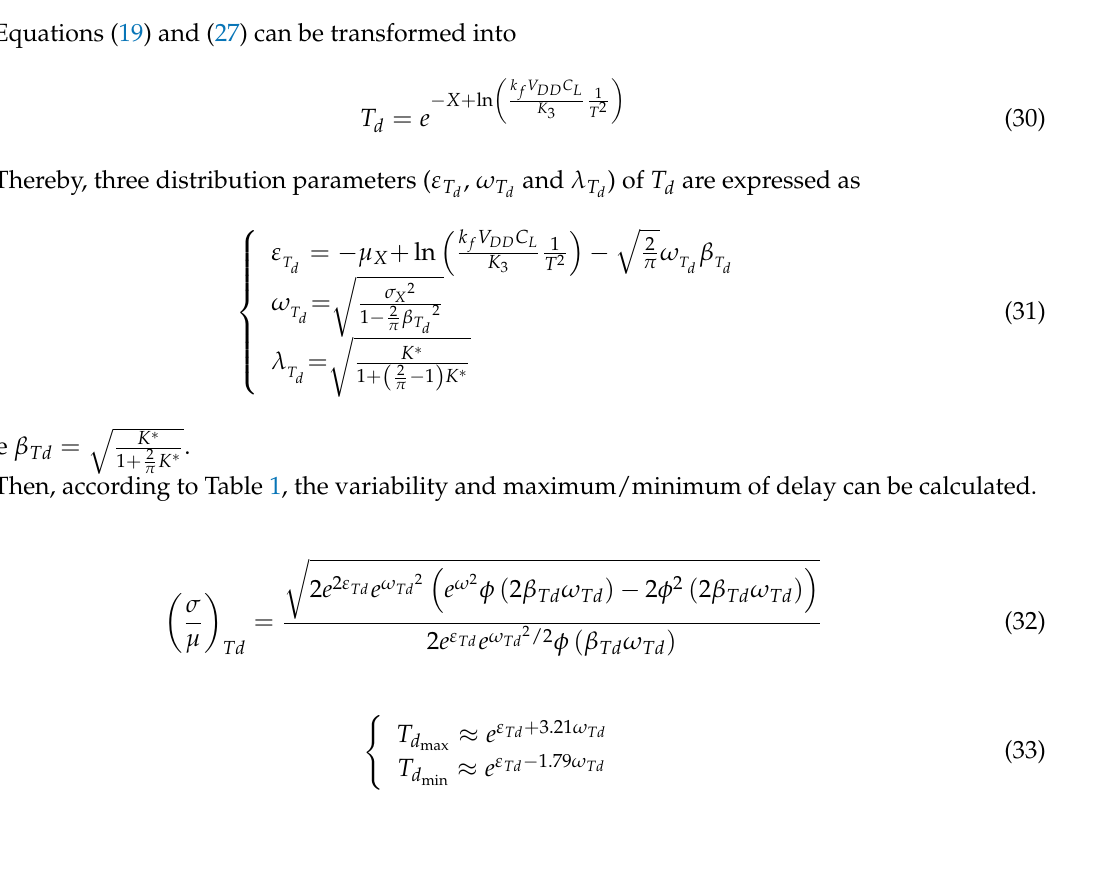
Figure 3. Flowchart of moment matching of log-skew-normal ( LSN